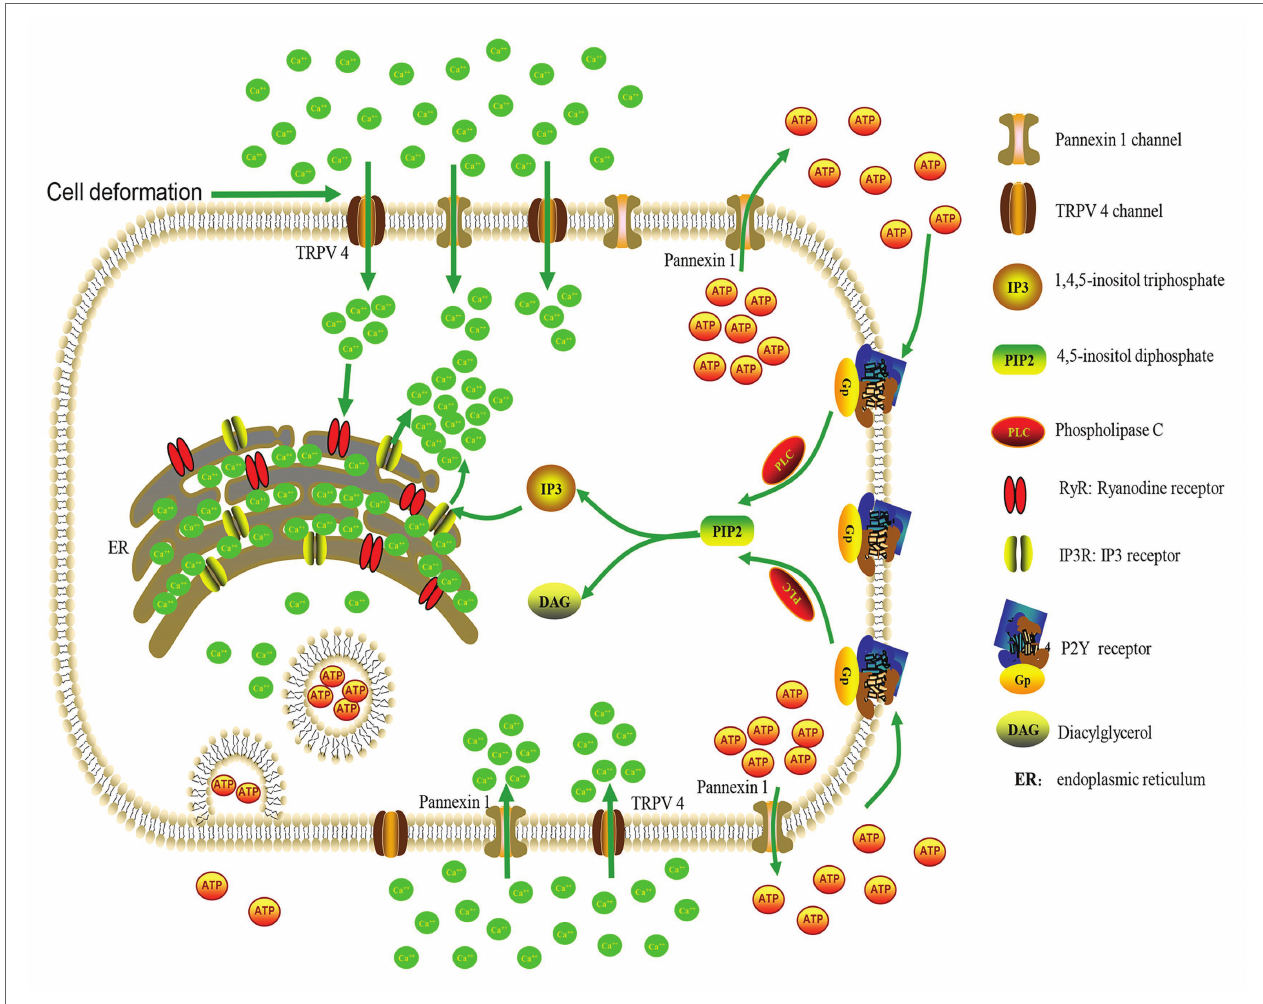
FIGURE 7 | A working model of cellular mechanisms for ALI-induced a [Ca 2+ ] i increase. Cell deformation activates membrane-bound TRPV4 or pannexin 1 channels to cause Ca 2+ influx and [Ca 2+ ] i increase, which in turn activates IP3 or ryanodine receptors on the endoplasmic reticulum (ER) to induce Ca 2+ release from intracellular Ca 2+ stores to further increase the [Ca 2+ ] i levels. The activation of pannexin 1 channels or the [Ca 2+ ] i increase can lead to ATP release, through nonvesicular or vesicular mechanisms, respectively. ATP further enhances the [Ca 2+ ] i increase by acting on P2Y receptors to increase IP3 level and Ca 2+ release from Ca 2+